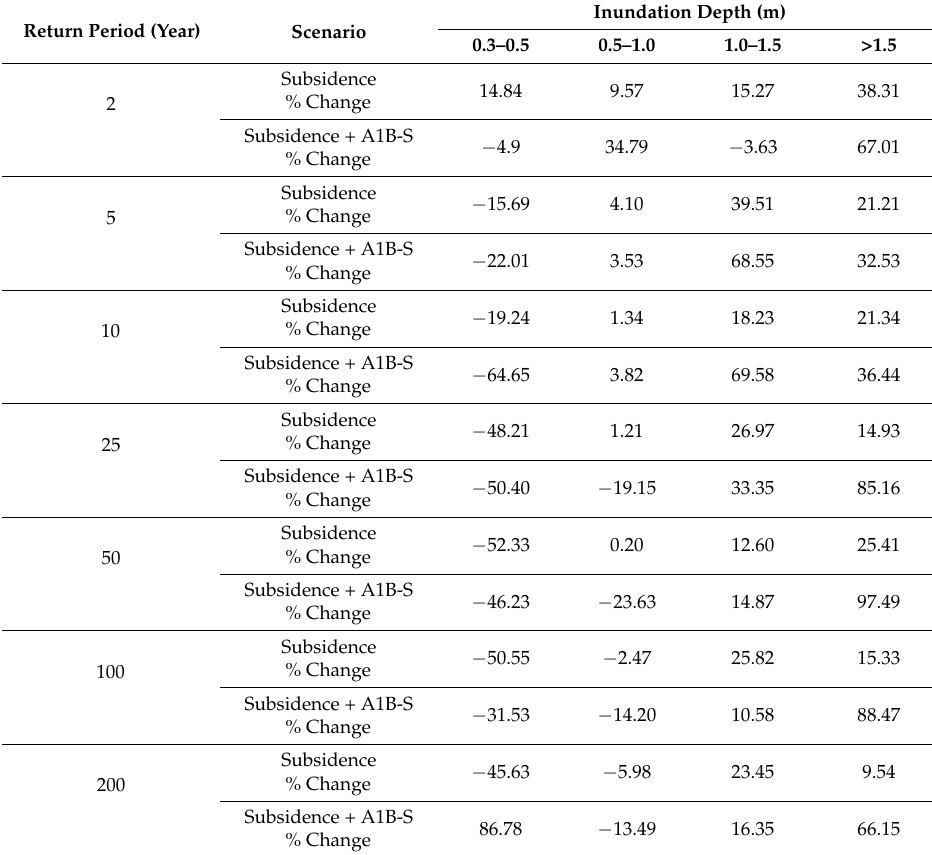
Table 5. Percentage of inundation area increase for one-day storm under different return periods and scenarios.